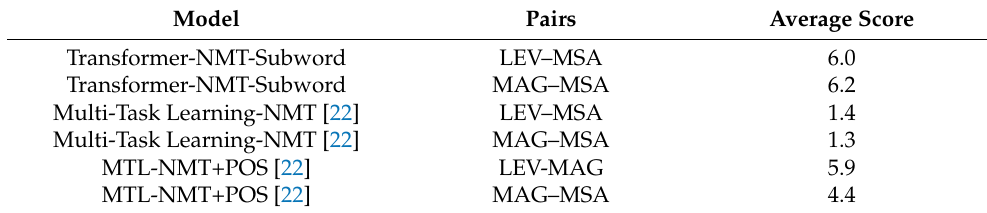
Table 10. Human Evaluation Scores -PRE for Levantine Arabic (LEV) and Maghrebi Arabic